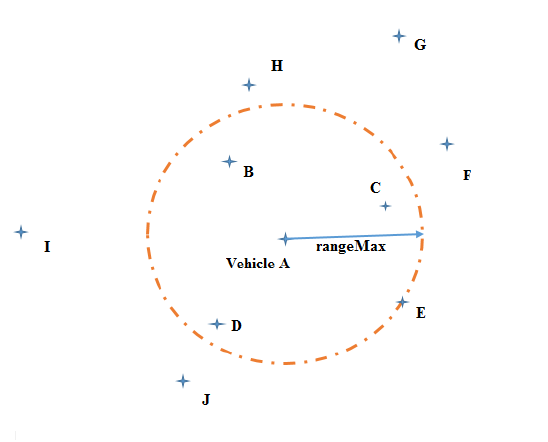
Figure 5. Maximum range around vehicle A : Vehicles B , C , D , and E are within vehicle A ’s